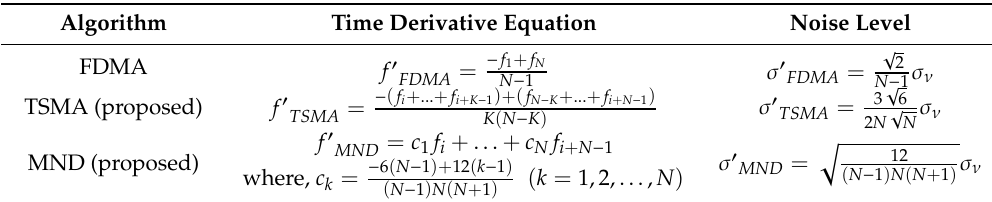
Table 1. The time-derivative equations and the noise levels of the conventional (FDMA) and the proposed (TSMA, MND)